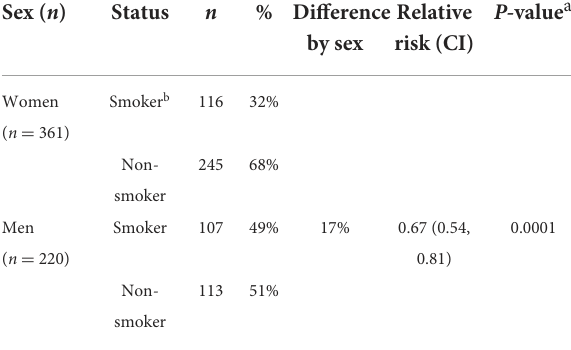
TABLE 2 More men than women with Sjögren’s disease are smokers ( n = 581).